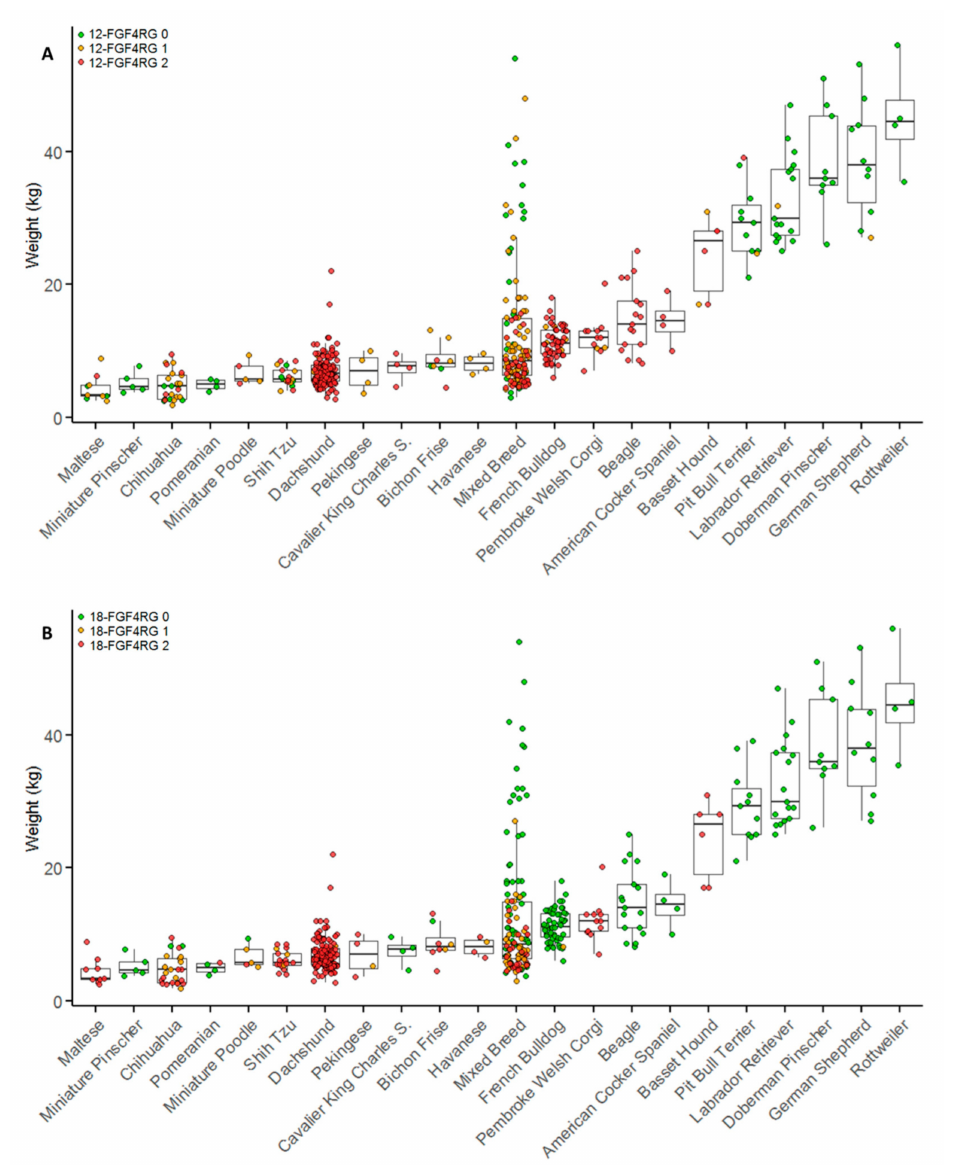
Figure 1. Breed and genotype distribution of surgical IVDD cases by body weight. Breeds with fewer than four cases are not included in this figure. Breeds are plotted in order of ascending median weights and colored by 12- FGF4 RG genotype ( A ) and 18- FGF4 RG genotype ( B ) n = 510). Red indicates two copies of each retrogene, orange indicates one copy, and green indicates zero